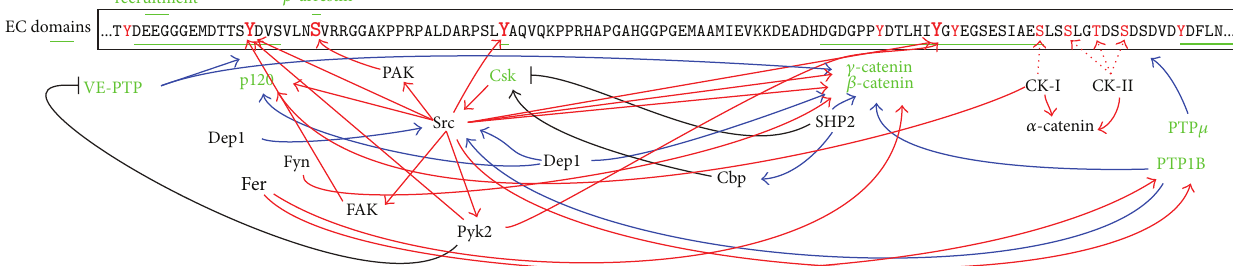
Figure 4: The net effect on cadherin tail phosphorylation depends on the action of multiple kinases and phosphatases. The VE-cadherin cytoplasmic region contains multiple phosphorylatable residues (in red) located in or near the JMD and CBD domains responsible for catenin binding (marked in green). Larger font highlights tyrosines 658, 685, and 731, together with serine 665, which have been more intensely studied. The overall phosphorylation status is the effect of a network of kinase (red arrows) and phosphatase (blue arrows) activities. These kinases and phosphatases can modify the cadherin tail and/or associated catenins directly or indirectly via the regulation of other associated kinases and phosphatases. Dotted arrowheads: CK-I and CK-II activity was shown to phosphorylate homologous residues in E-cadherin